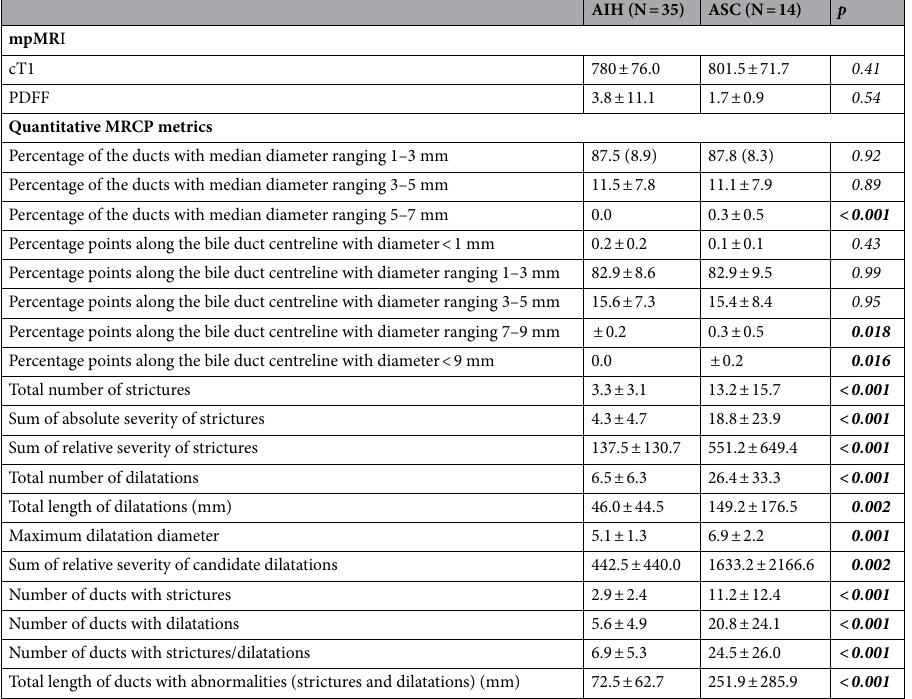
Table 2. Quantitative MRCP and mpMRI data per AILD cohort (AIH vs. ASC)—report Median and IQRs. The different section headings, significant p values, and patient groups in the column headers have bold font. They have been put in bold text to aid in the interpretation of the data